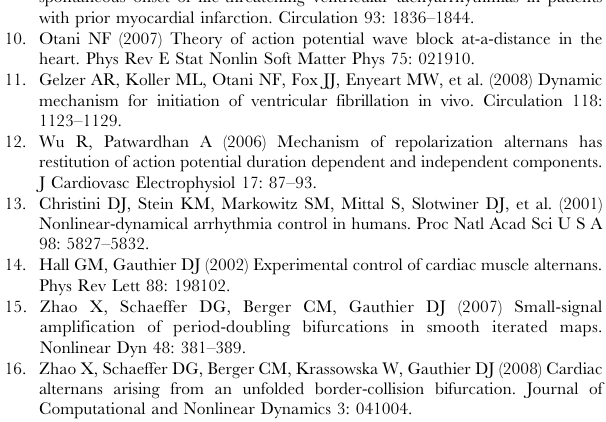
Figure S1 Cycle length oscillation in a one-dimensional cable ionic model. V m and Ca i before and during CLO along the length of the cable. Traces from the pacing site (x= 0 cm) are the lowermost of the stacked traces. L and S indicate long and short APDs and large and small Ca i transient amplitudes, respectively. Figure S2 Alternans in the pseudo-ECG. A. V m and pseudo-ECG (pECG) before and during CLO. Red lines indicate timing of point stimuli. At the top, pECG is shown on an expanded time scale, and the QRS complex, T wave, QT interval, and RR interval are identified. B. CL, RR interval, QT interval, R wave magnitude, and T wave magnitude plotted as a function of time. Black arrows indicated phase